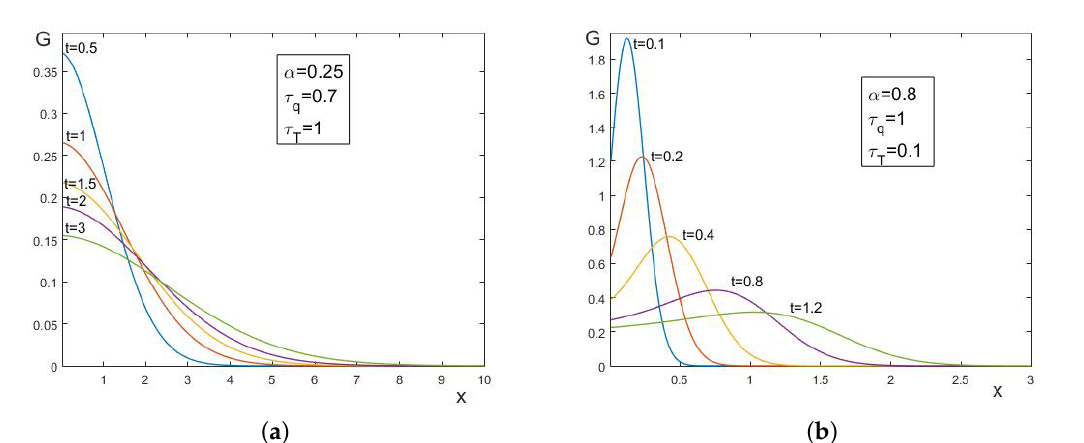
Figure 1. Plots of the the fundamental solution G 1 ( x , t ) versus x ( x > 0) for different values of t ; ( a ) diffusion regime ( τ q < τ T ); ( b ) propagation regime ( τ q > τ T